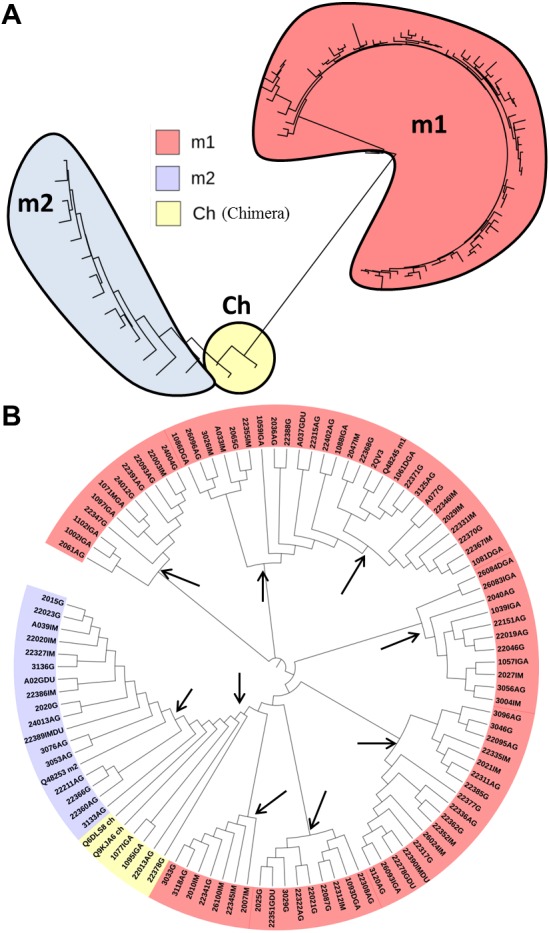
Phylogenetic tree of p55 VacA from H. pylori of Colombian mestizos.The tree was inferred using the Neighbor-Joining method (Saitou & Nei, 1987). (A) The tree is drawn to scale, with branch lengths in the same units as those of the evolutionary distances used to infer the phylogenetic tree. The topology robustness was calculated using the averages of 2,000 replicates from the bootstrap test (Felsenstein, 1985). Only significant consensus tree branches are shown. The evolutionary model that best fitted the alignment was the JTT+G+F+I (Jones, Taylor & Thornton, 1992) showing a BIC (Bayesian Information Criterion) = 15,807, lnL = −6,341,5. The rate variation among sites was modeled with a gamma distribution = 2. The analysis involved 101 amino acid sequences. All positions containing gaps and missing data were eliminated. Evolutionary analyses were conducted in MEGA7 (Kumar, Stecher & Tamura, 2016). (B) The phylogenetic tree without distances showing discrete clades (arrows) accounting for the diversification of the domain in the studied samples.